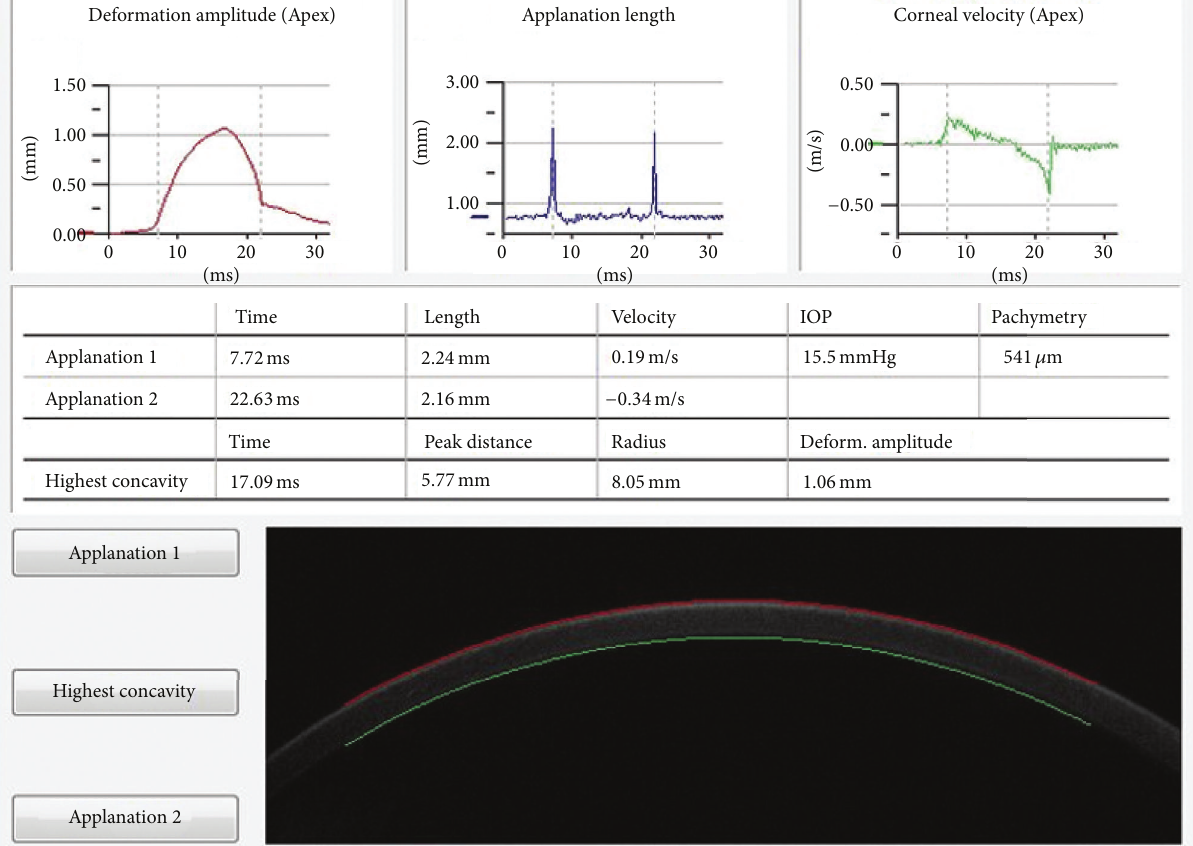
Deformation amplitude (Apex)